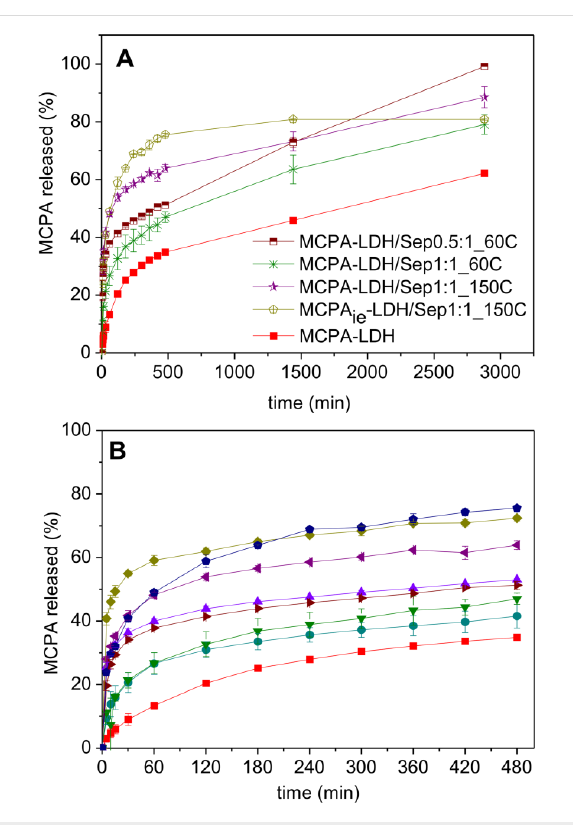
Figure 7: (A) In vitro release of MCPA from the hybrid formulations in deionized water (pH approx. 5.5), and (B) zoom of the same graph showing the release behavior in the first 500 min of the